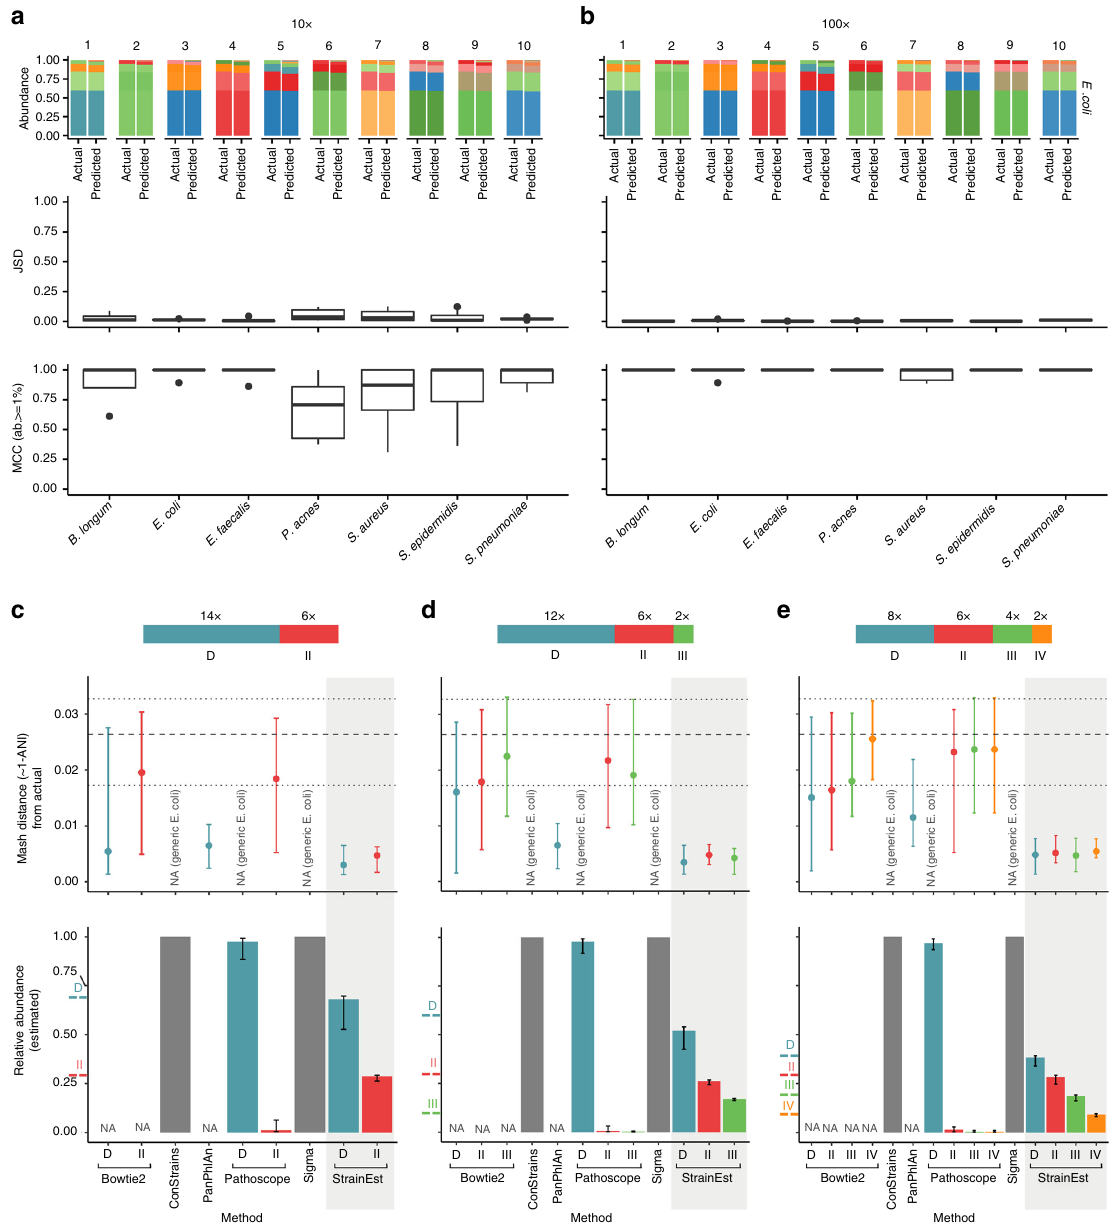
Fig. 2 Validation on synthetic data and comparison with existing tools. StrainEst is able to predict the relative abundances of multistrain synthetic mixtures for different species such as B. longum , E. coli , E. faecalis , P. acnes , S. aureus , S. epidermidis , and S. pneumoniae . For each species, we simulated 10 synthetic data sets at coverage 10X ( a ) and 100X ( b ) generating reads from four strains mixed at variable relative abundances (60-25-10-5%). In the upper panel, we show the comparison between real and predicted relative abundances for E. coli . Colors indicate different strains. In the middle panel, we show the JSD between actual and predicted strain composition. In the lower panel, we show the MCC between the real and predicted strain composition, discarding strains with predicted relative abundances below 1%. As expected, the accuracy of StrainEst grows with increasing coverage. Boxes extend to the fi rst and third quartile, whiskers extend to the upper and lower value within 1.5*IQR from the box. Outliers are shown as points. c – e Upper panels: distance between the dominant (D) and the second (II), third (III), and fourth (IV) most frequent strain predicted by Bowtie 2, ConStrains, PanPhlAn, PathoScope, Sigma, and StrainEst for the three synthetic data sets composed of 2, 3, and 4 strains of E. coli . NA (generic E. coli ) indicates that the algorithm only predicted the presence of E. coli without further speci fi cation. The broken lines indicate the 25th percentile, median, and 75th percentile of the distribution of the pairwise Mash distances between pairs of strains randomly chosen from the 3041 E. coli genomes downloaded from NCBI. Lower panels: Predicted relative abundances of the identi fi ed strains. The expected relative abundances are marked in colors (D, II, III, and IV for the dominant, second, third, and fourth strain in terms of relative abundances, respectively) on the vertical axes. Error bars indicate the fi rst and third ConStrains 11 and simple read alignment on reference genomes genomes and the low coverage of SNV sites (Supplementary Table 3). using Bowtie2 18 (Fig. 2c – e). PanPhlAn and MIDAS, despite being able to determine the taxonomic structure of metagenomic samples To highlight the potentialities and the novel features of StrainEst, with strain-level resolution were not speci fi cally designed to we compared to PanPhlAn 7 , MIDAS 8 , PathoScope 12 , Sigma 13 ,